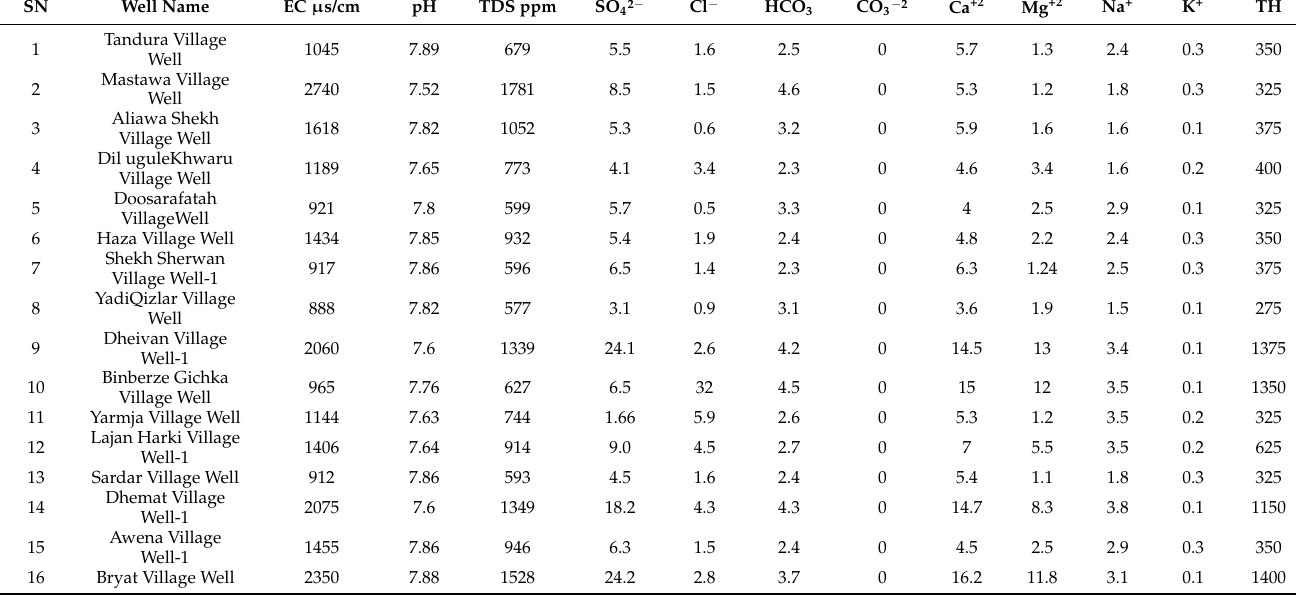
Table 7. Physico-chemical Parameter Analysis for the Deep Wells in the study area, cations and anions in mole/m 3